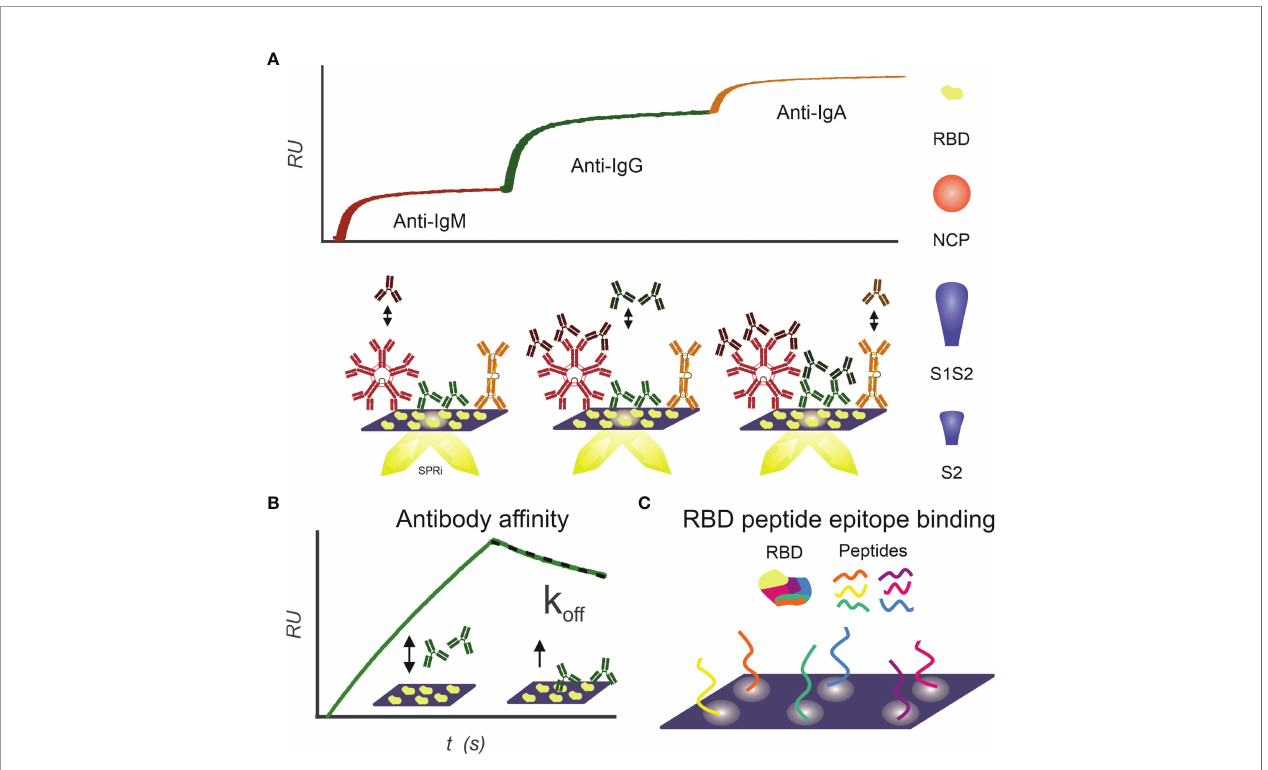
( Figure 1A ). Brie fl y, an SPRi sensor of a speci fi c antigen was